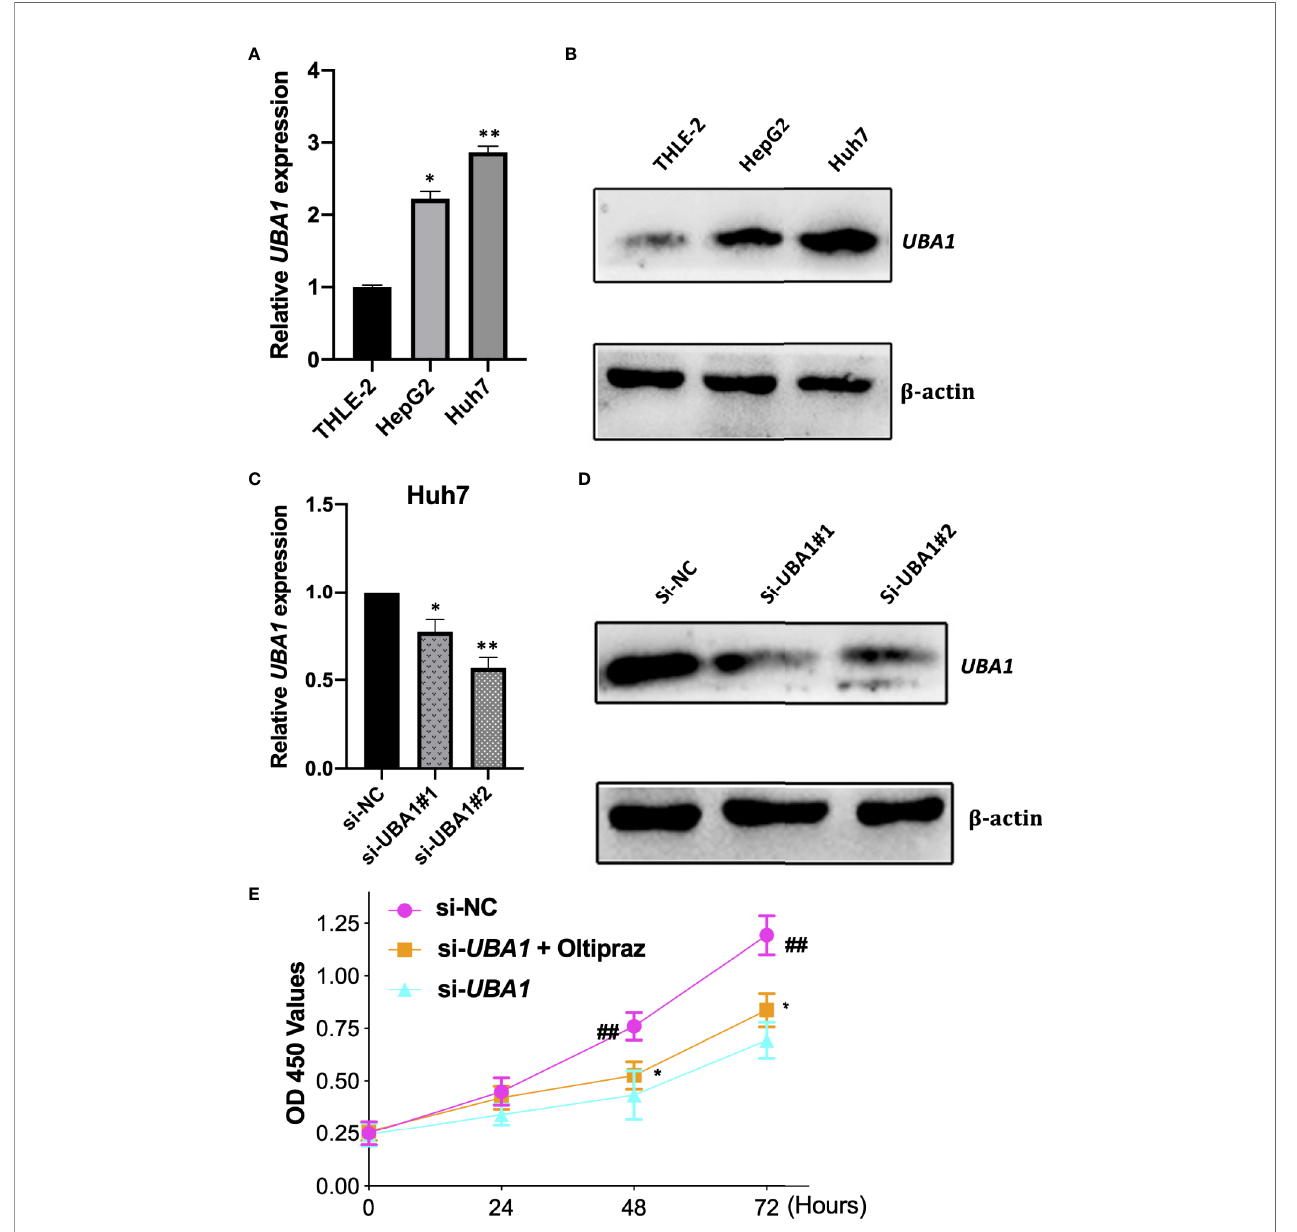
FIGURE 7 | Veri fi cation of UBA1 levels inHCC cells. (A, B) UBA1 expression insome HCC celllines was detected by qRT – PCR andWestern blotting. (C, D) Effects of UBA1 interference within Huh7 cellsat the mRNA or protein level. (E) Cellproliferation ability detected byCCK-8 viability following UBA1 expression interference. (* p < 0.05; ** p < 0.01; ## p <